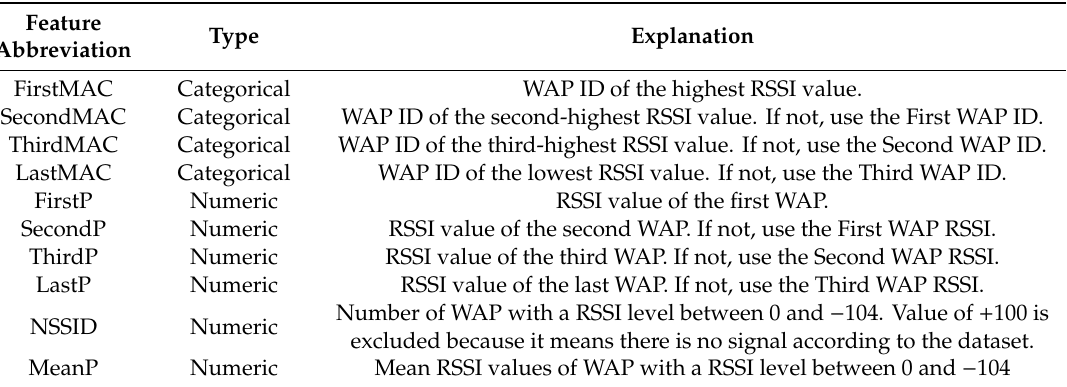
Figure 3. Absolute cross-correlation coefficients of dataset. Table 2. Generated features.